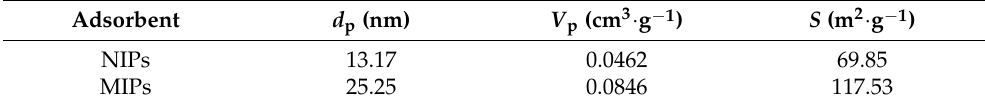
Table 1. Surface areas, pore volumes, and pore sizes of the MIP and NIP microspheres.